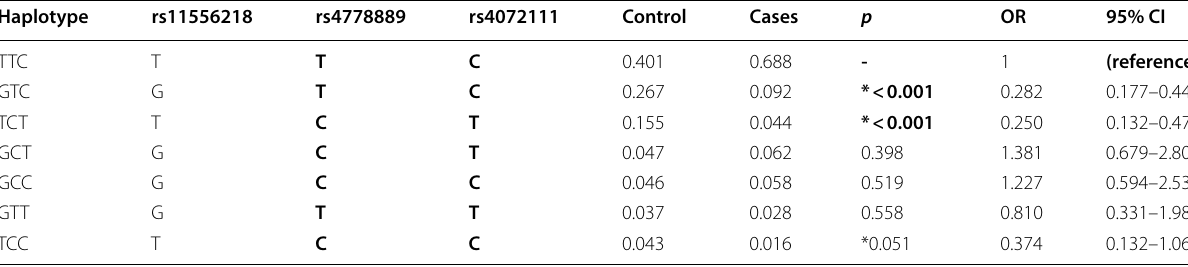
OR Odds ratio, CI Confidence interval * Significance P ≤